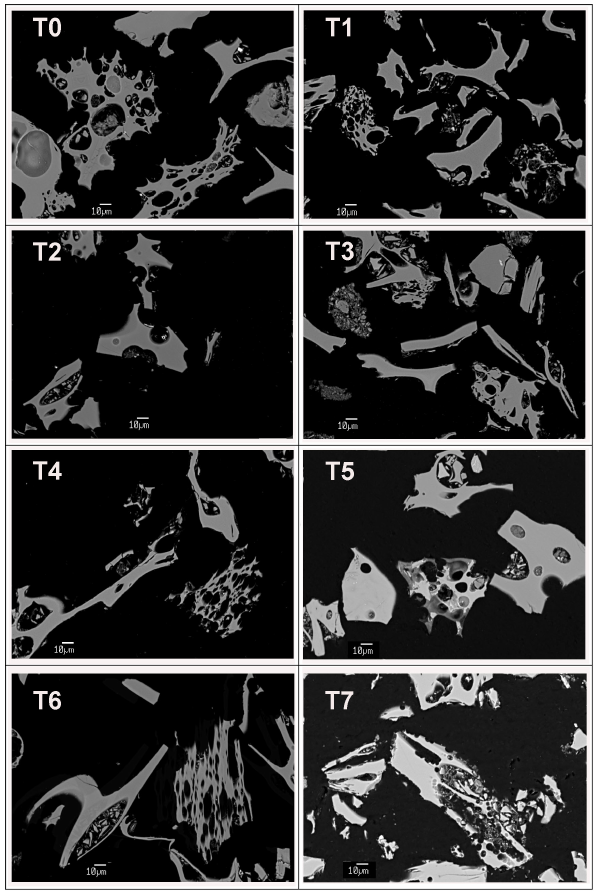
Figure 3. Backscatter electron images of characteristic glass shards from tephra layers T0–T7 from Lake El’gygytgyn. Scale bar is 10µm.